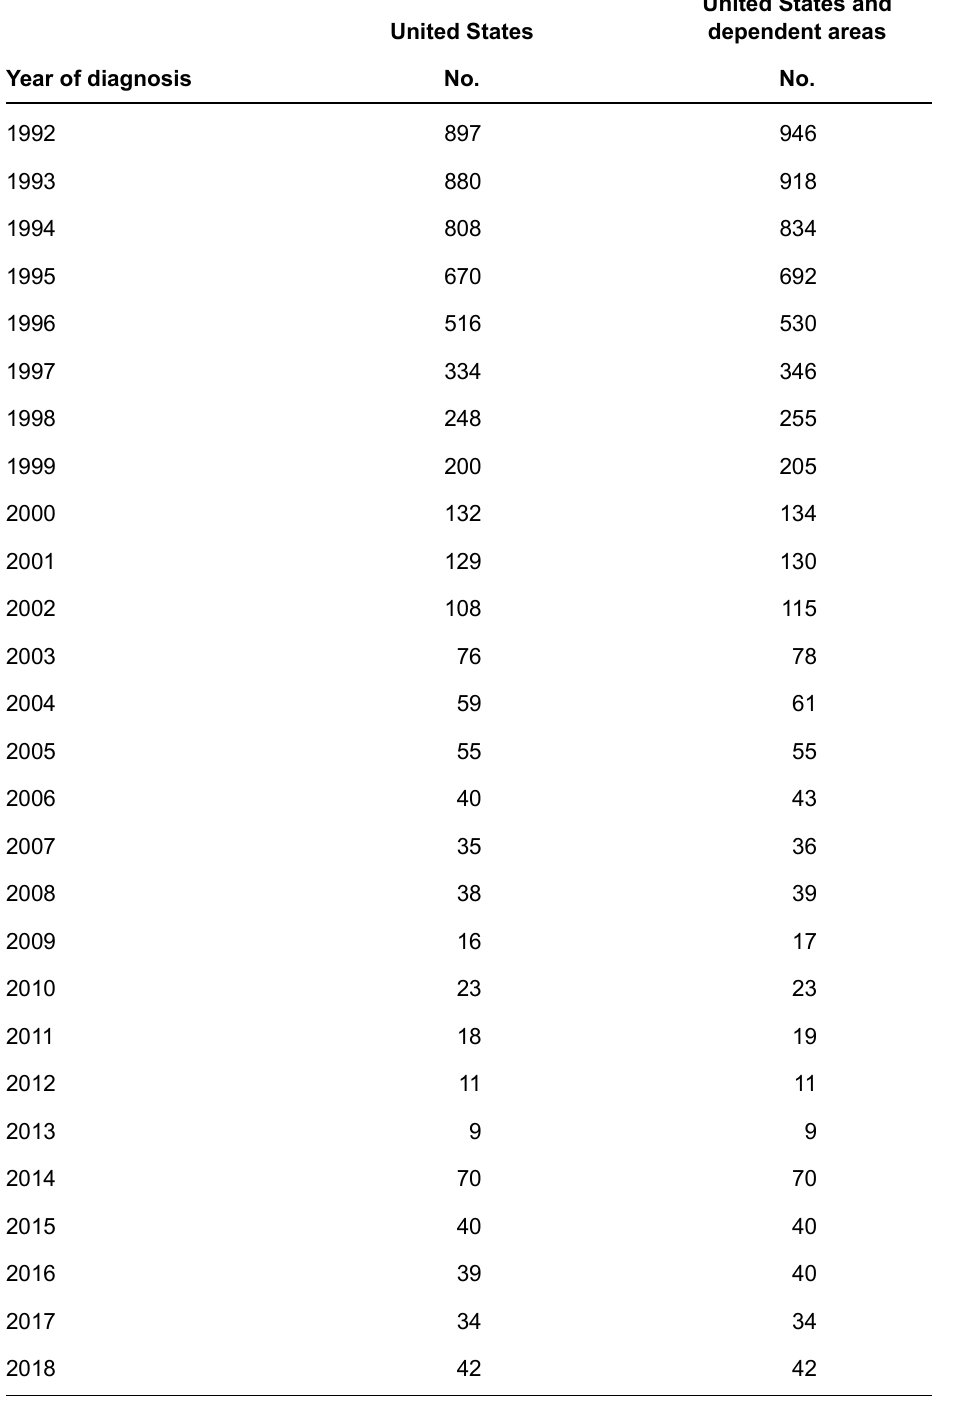
Table 15. Stage 3 (AIDS) among children aged <13 years, by year of diagnosis, 1992–2018—United States and 6 dependent areas United States and United States dependent